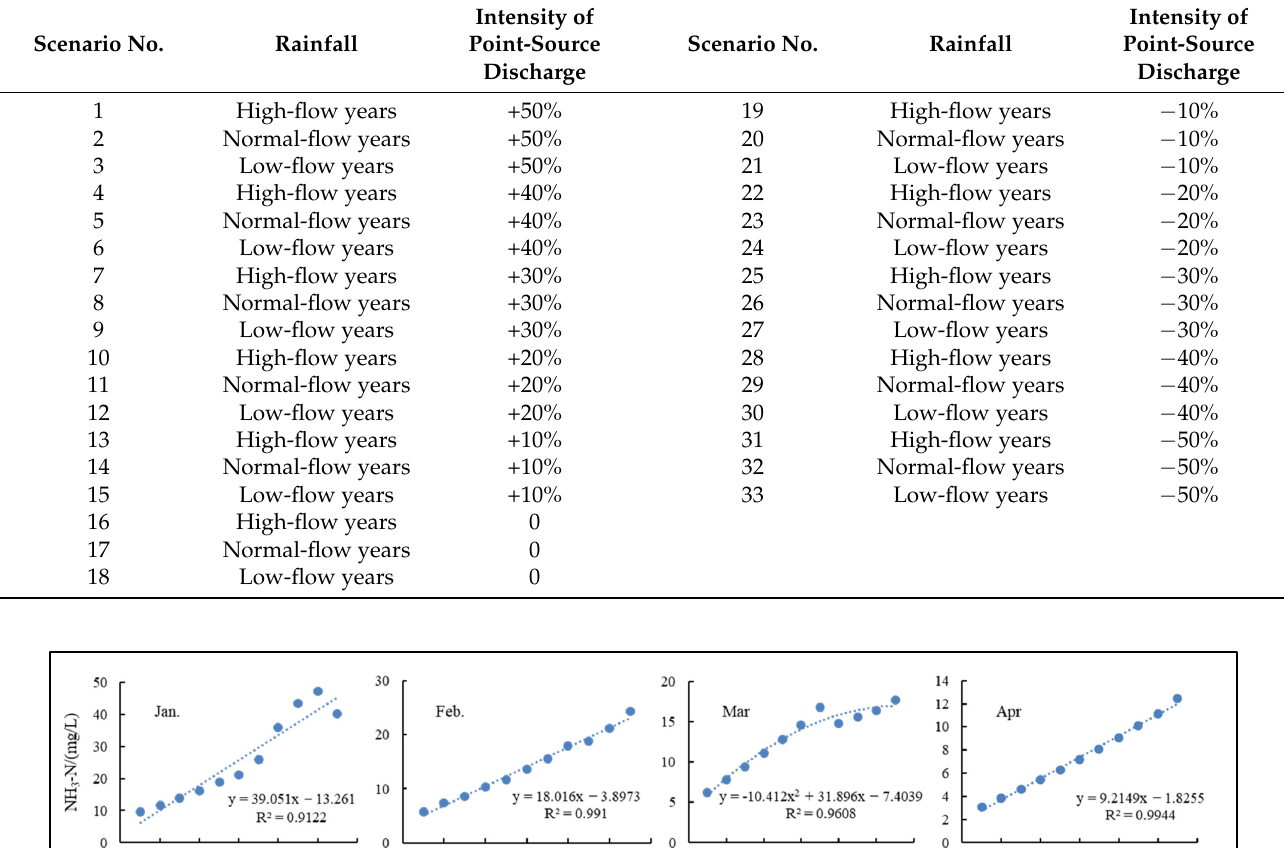
Table 5. Combined scenarios of rainfall and point-source discharge.